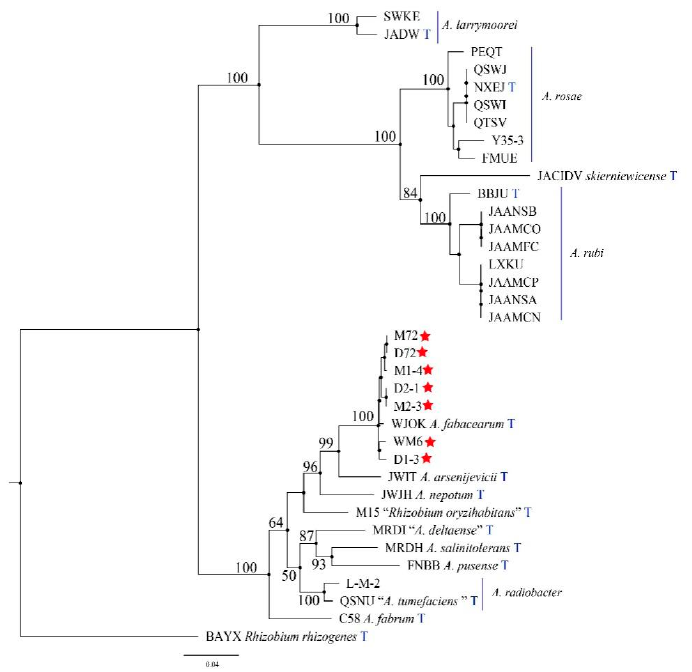
Figure 6. A phylogenetic tree inferred from combined analysis of atpD-gyrB-recA-rplB gene sequences for a number of species selected from Agrobacterium and Rhizobium . Bootstrap support values over 90% for maximum likelihood (ML), and the Bayesian posterior probabilities are based on 1000 bootstrap replicates. Ex-type strains are marked by an asterisk. The tree was rooted to Rhizobium rhizogenes .